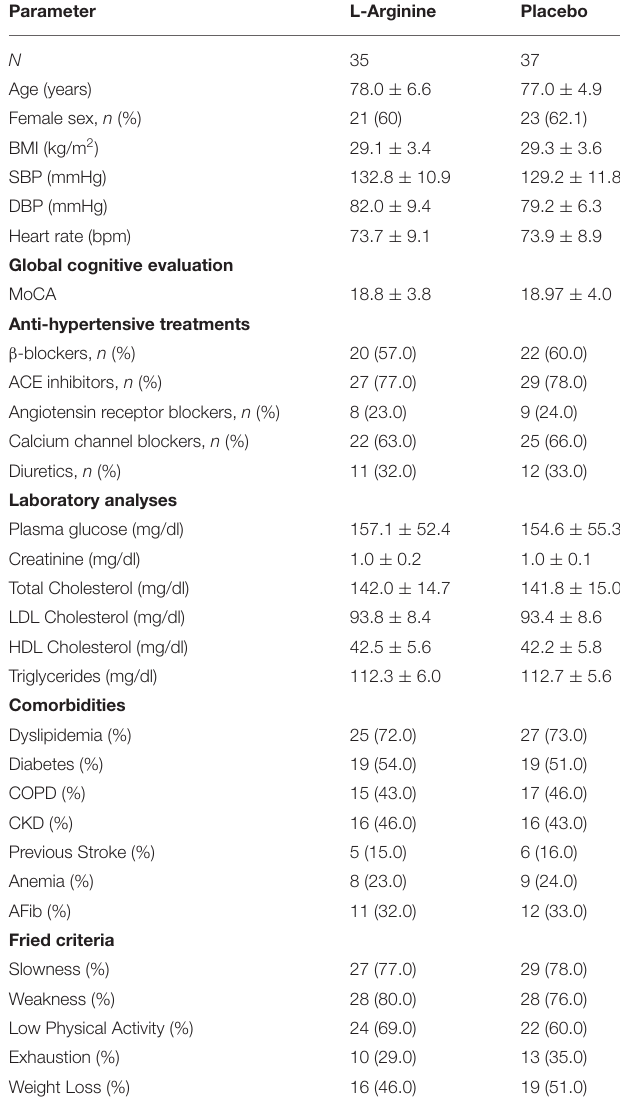
TABLE 1 | Baseline clinical characteristics of our